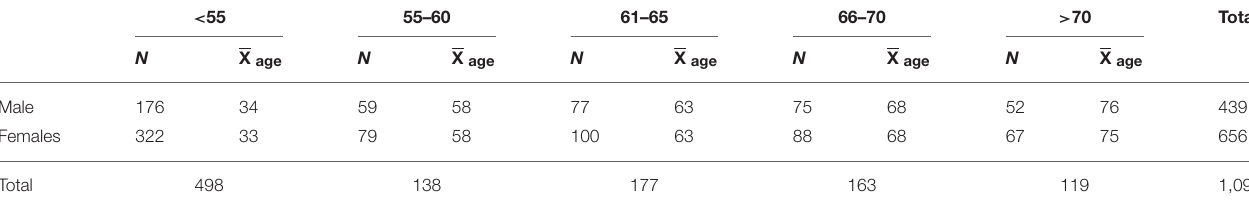
TABLE 1 | Distribution of participants by age and sex ( n =